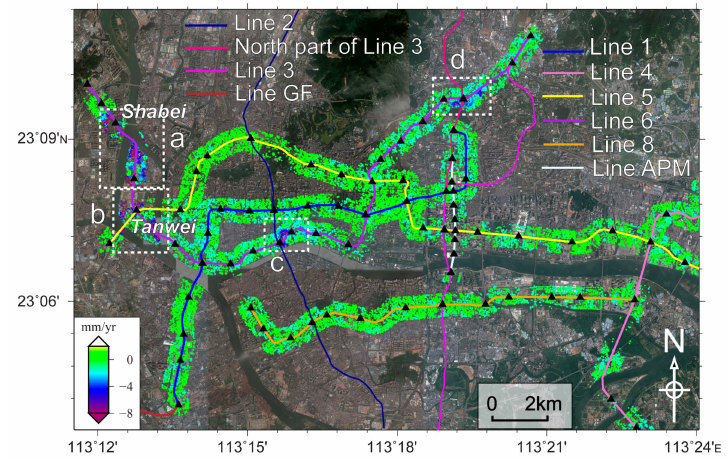
Figure 6. PALSAR deformation rate map of Lines One, Four, Five, Six, Eight, and APM. The dashed rectangles mark the subsiding areas along Line Six, which are detailed in Figure 7a,b.